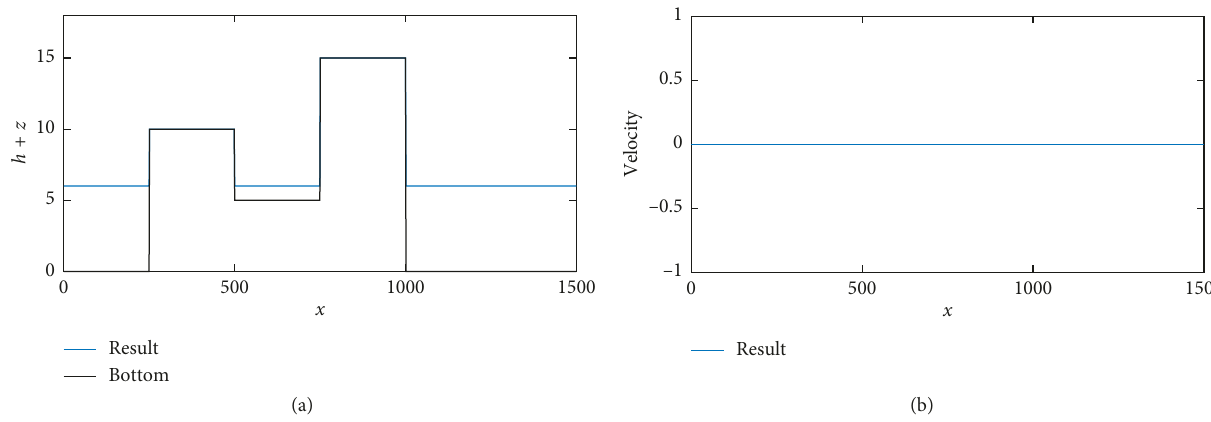
Figure 2: Water depth (a) and velocity (b) of wet/dry still water stationary state at final time